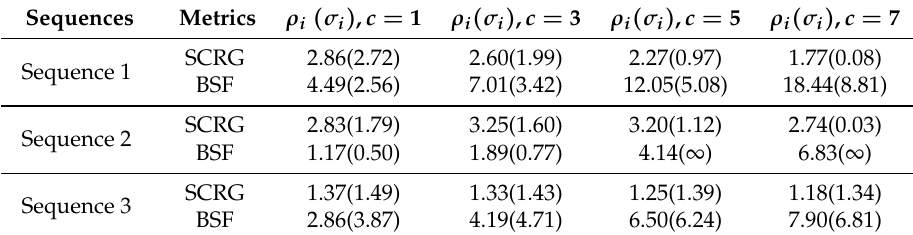
Table 3. Average scores of the dense reconstruction maps with different